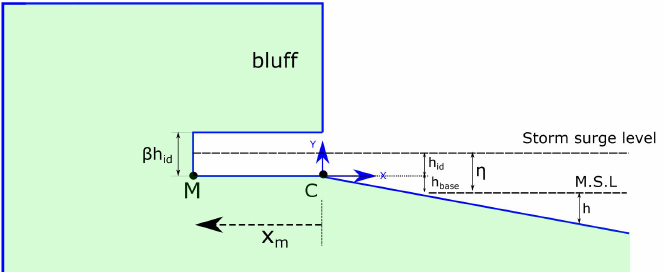
Figure 5. Definition of geometrical parameters to estimate the growth of the niche (as per the work in [21]). Point C in the figure is the origin of coordinates (0,0), x m = the depth of niche, h id = the inundation depth at the base (assumed constant during the time-step of the global model and calculated as h id = ( η − h base ), M is the niche melting front advancing inward, and β h id is the opening of the